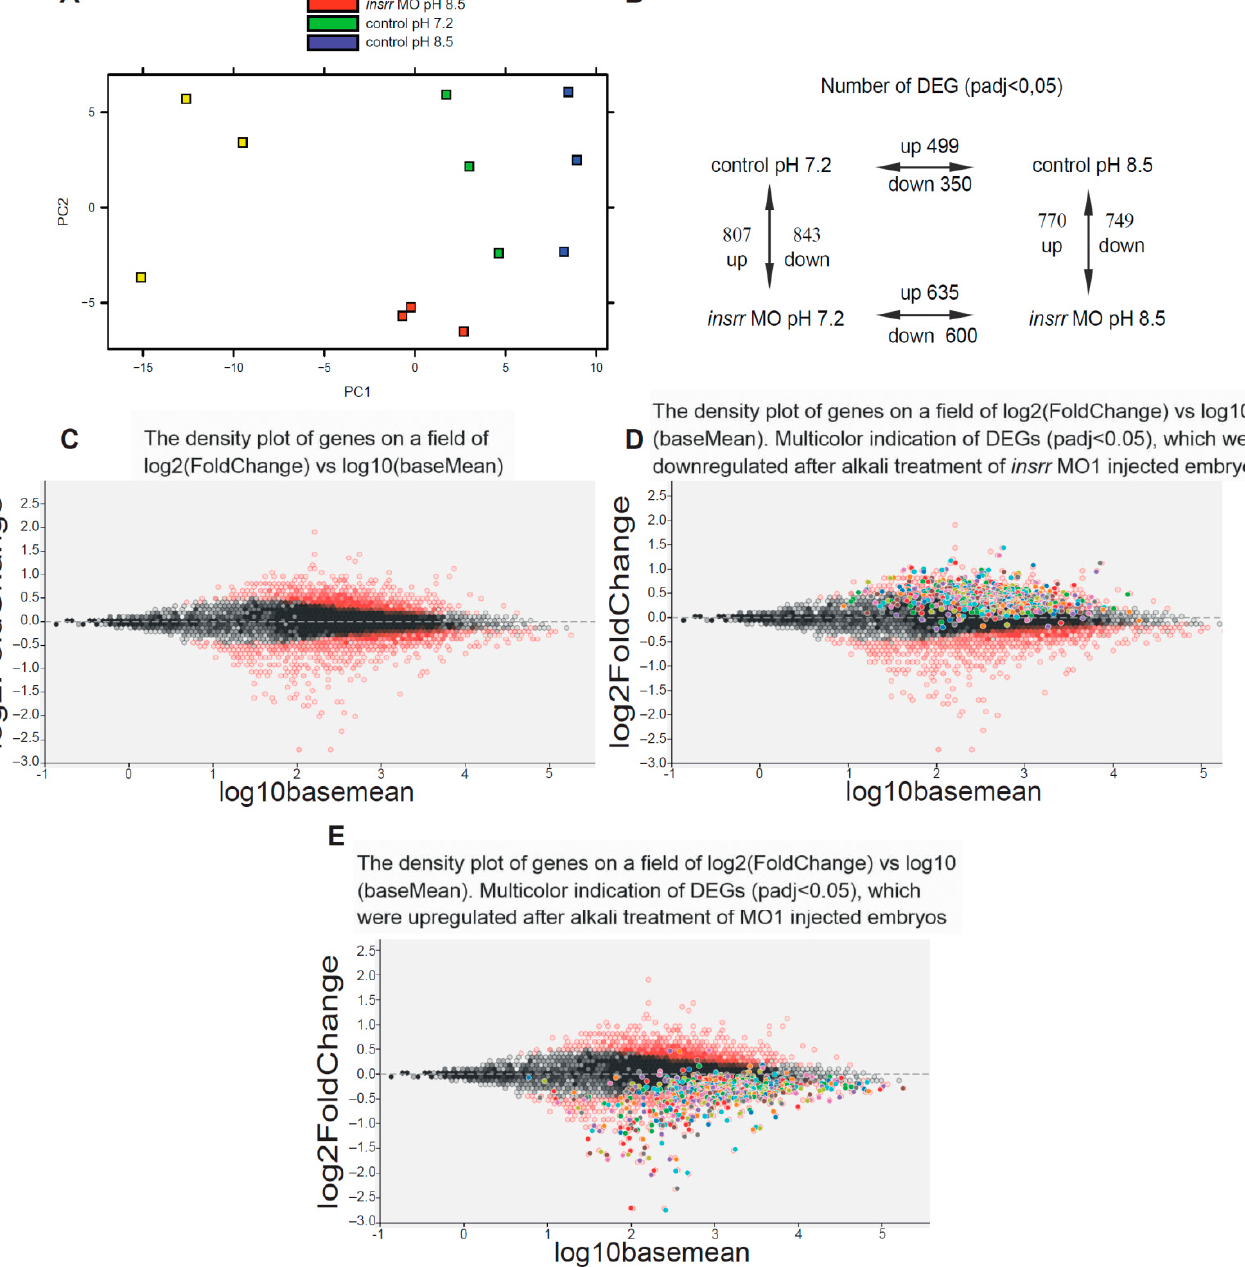
and most downregulated insrr MO 7.2/control MO 7.2 DEGs (Table 1) using the